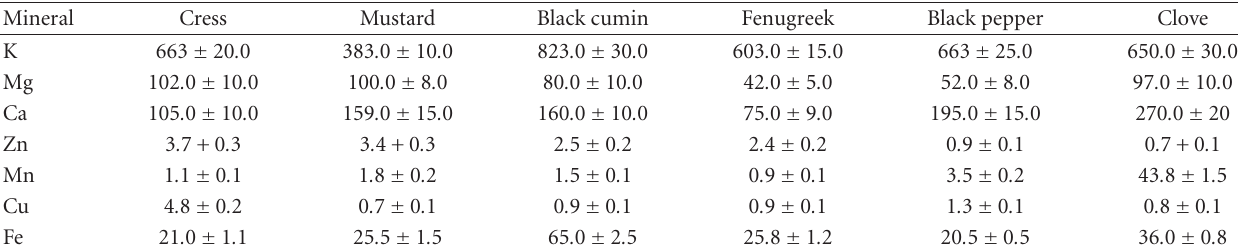
Table 2: Mineral content (mg/100g) of cress, mustard black cumin, fenugreek, black pepper, and clove seeds ∗ . Mineral